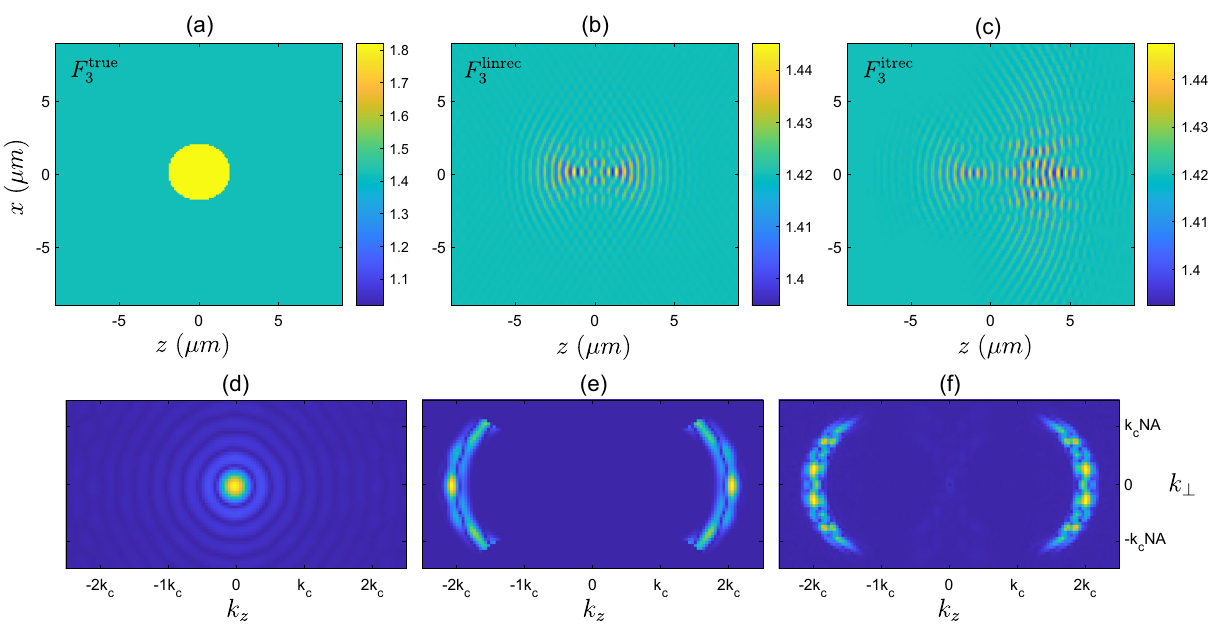
Figure 6. ( a ) Refractive index corresponding to the scattering potential of the high contrast disk sample F 3 . ( b ) Refractive index corresponding to the linear reconstruction F linrec 3 . ( c ) Refractive index corresponding to the iterative solver reconstruction F itrec 3 . ( d ) Magnitude of Fourier transform, |˜ F true 3 ( k ) disk sample. ( e ) Magnitude of Fourier transform of true sample after being filtered |˜ F true 3 ( k ) Magnitude of Fourier transform of the reconstructed sample provided by the iterative solver, |˜ F itrec 3 ( k )